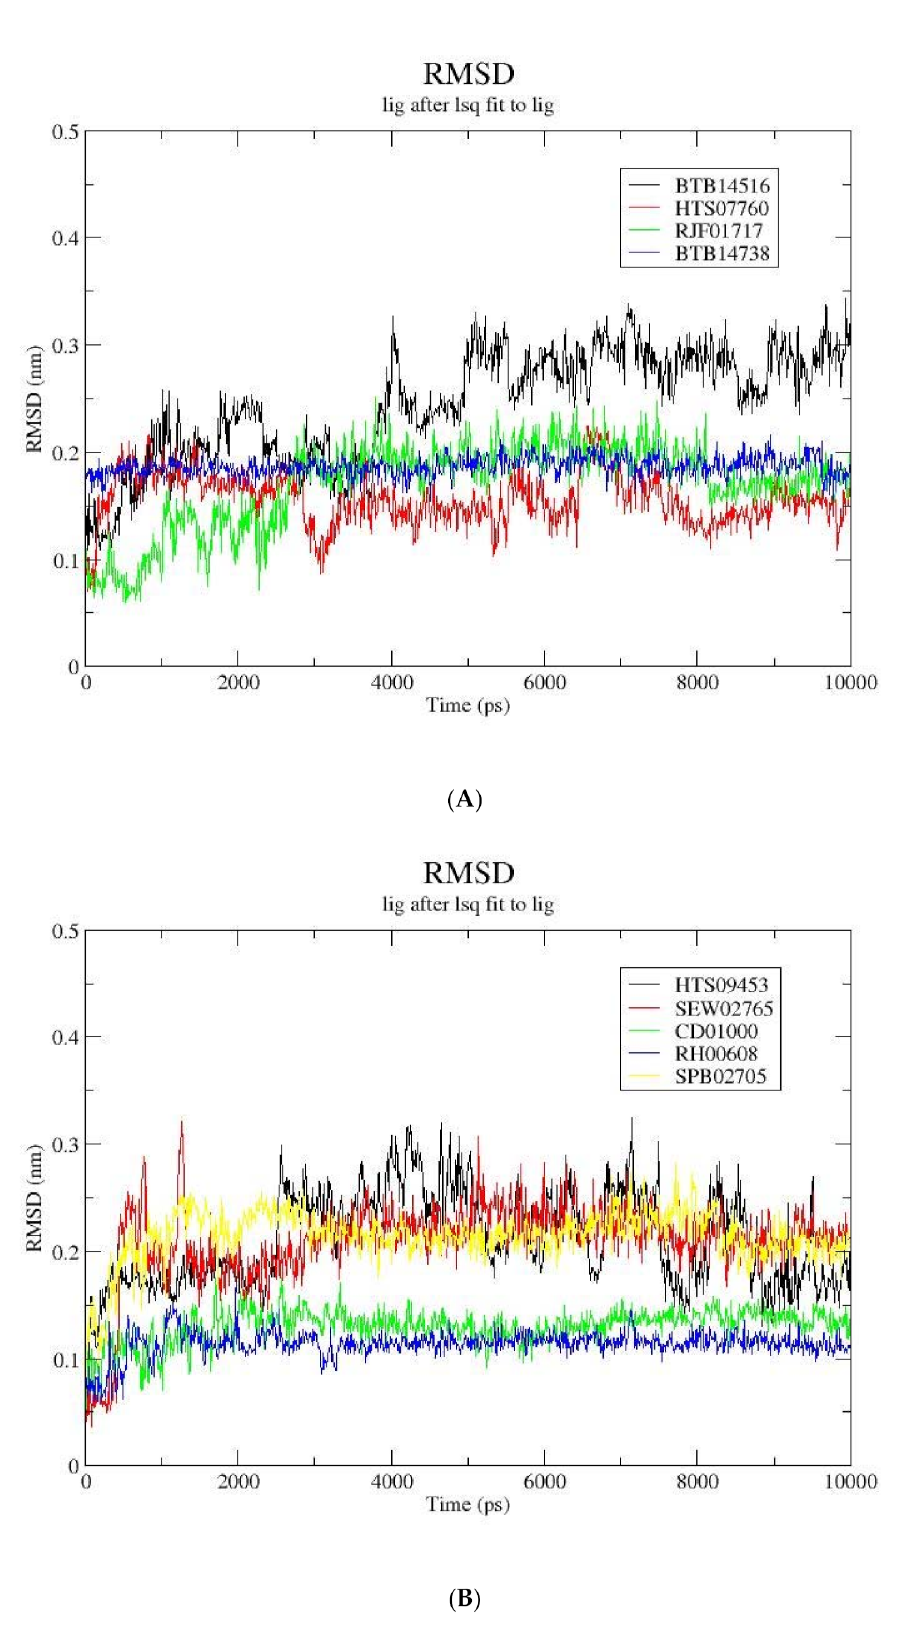
Figure 5. The r.m.s.d plots for ligand are given for ( A ) BTB14516, HTS07760, RJF01717, BTB14738 ( B ) CD01000, HTS09453, RH00608, SPB02705, and